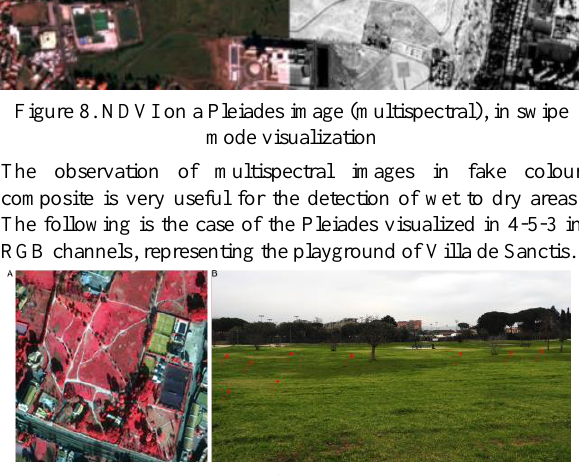
Figure 9. colour composite of the playground nearby Villa De Sanctis and, on the right frame (B), a picture of the same park taken during survey (A)